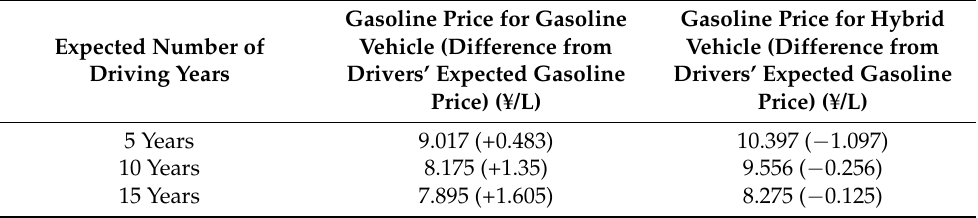
Table 11. Comparison between calculated gasoline price and drivers’ expected gasoline price trigger- ing EV purchase.